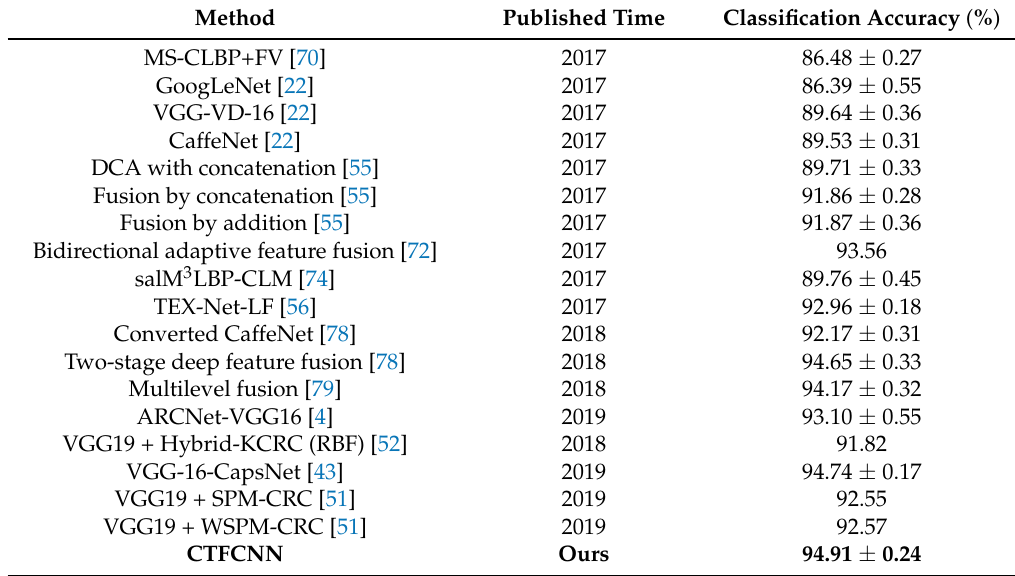
Table 3. Overall accuracy (mean ± SD) comparison of recent methods under the training ratio of 50% on the AID